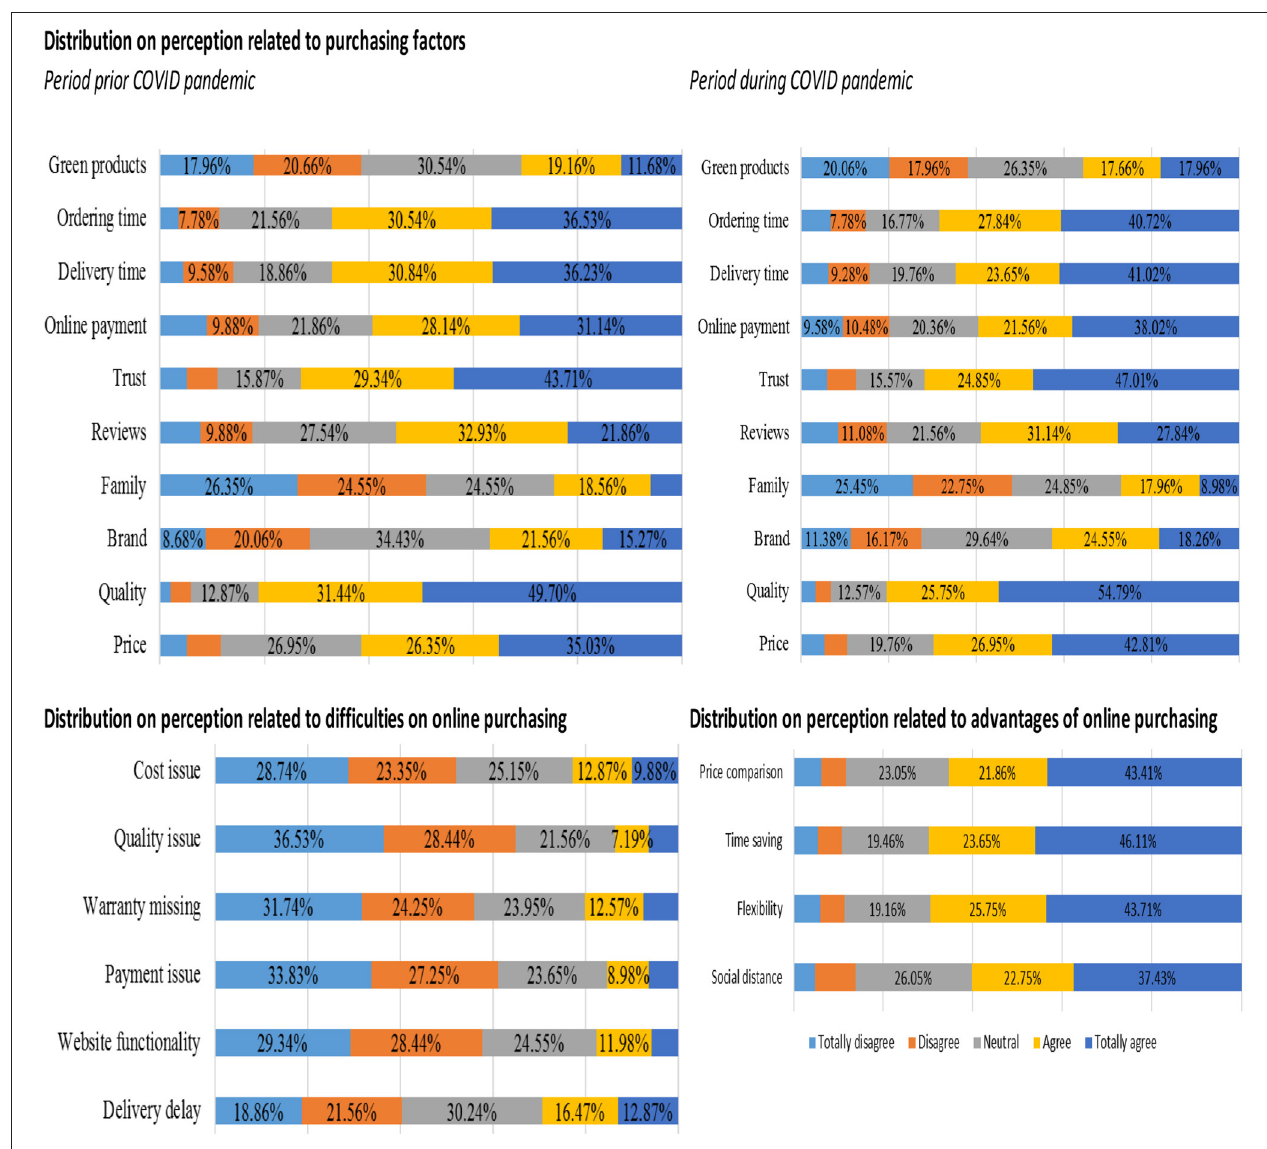
FIGURE 4 | Distributions on items reviewed on the questionnaire. Source: authors’